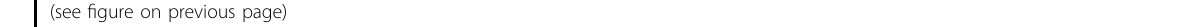
Fig. 5 Effect of gene silencing of EHF in HNSCC cells. A, B , and C After knocking out the indicated genes by CRISPR/Cas9 techniques, monoclones were established and examined by IB analysis ( A ), invasion assays ( B ), and chemoresistance assays in response to the indicated concentration (conc.) of docetaxel in OBC01 cells ( C ). D, E , and F OBC01 cells transfected with control siRNA (NC) or EHF siRNAs were subjected to IB analysis ( D ), RT-qPCR analysis ( E ), and chemoresistance assays in response to the indicated concentration (conc.) of docetaxel ( F ). The ratio of mRNA expression to GAPDH in cells transfected with control siRNA (NC) was indicated as “ 1 ” ( E ). Each value represents the mean ± s.d. of triplicate determinations from a representative experiment. Similar results were obtained in at least three independent experiments. p values were determined by Student ’ s t -test. * p < 0.01 ( C and F ). α -tubulin was used as a loading control ( A and D ). G and H Representative images of immunohistochemical staining with anti-EHF antibody are shown in normal tongue tissue (top left panel), tumor nest (top right panel), and the invasion front (bottom two panels). Arrowheads indicate basal layer cells in normal tissue. Black arrows, orange arrows, and blue arrows represent EHF-negative, EHF-weak, and EHF-positive cancer cells at the invasion front, respectively ( G ). After representative images at the invasion front were randomly selected, we evaluated EHF-positive or negative/weak cancer cells at the invasion front, which were further assessed according to the Anneroth ’ s criteria by pathologists ( H ). Student ’ s t -test was used to compare differences between groups. ** p <